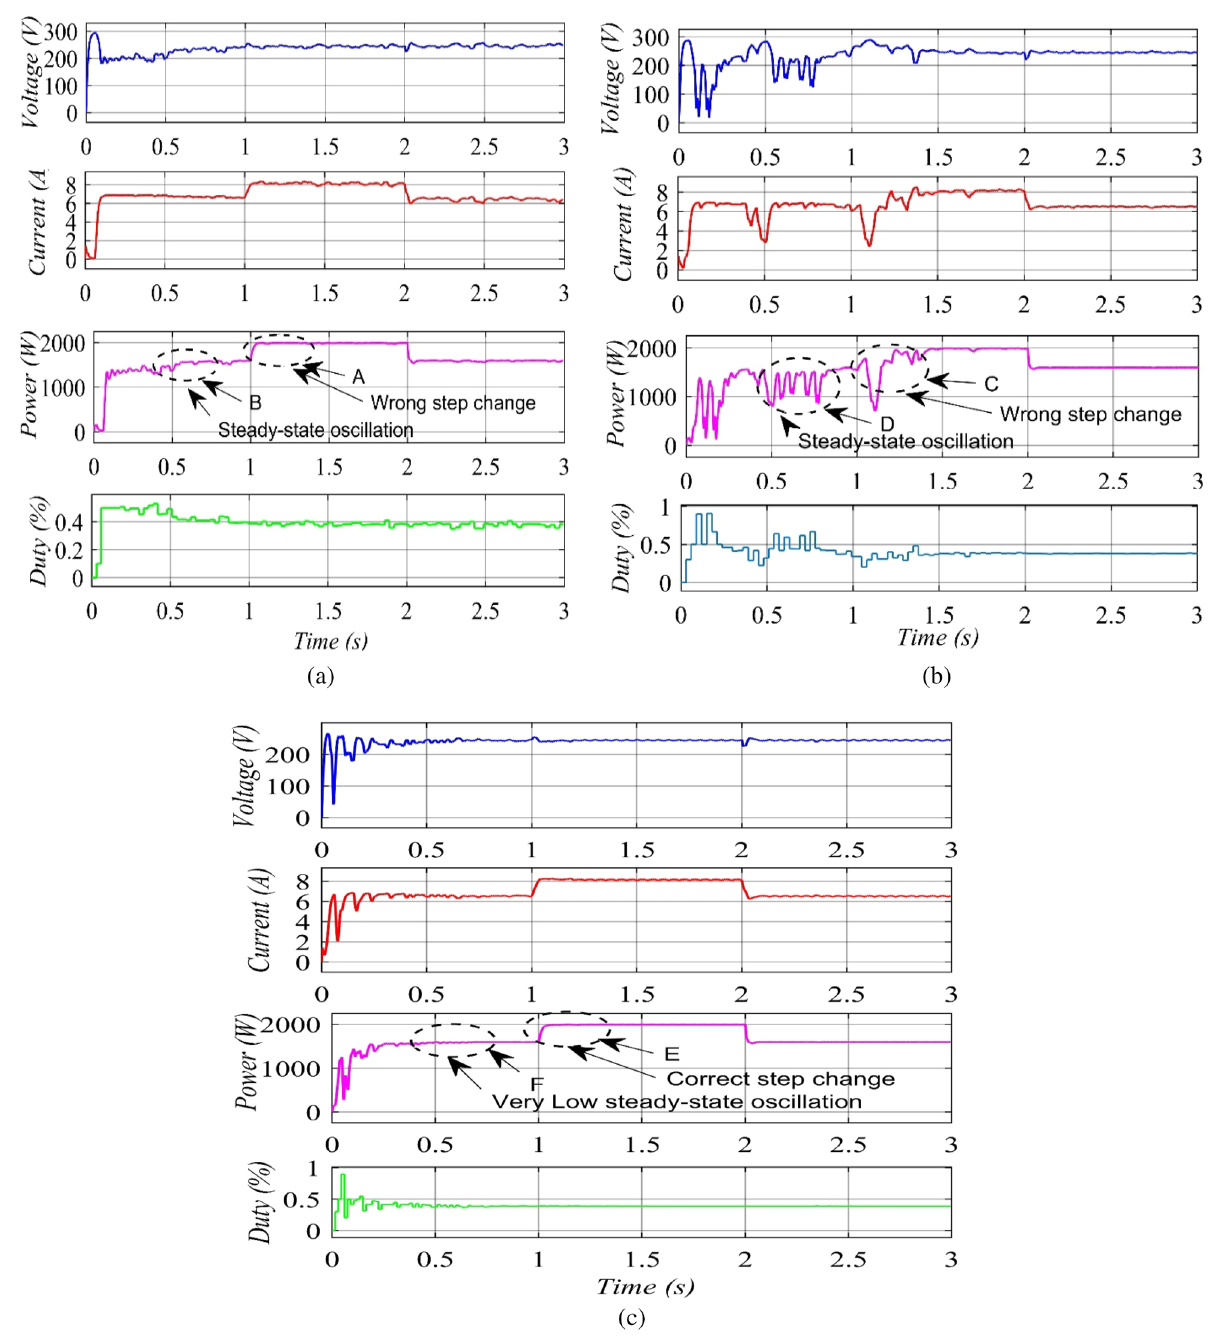
Figure 12. Simulation results: ( a ) TIC algorithm. ( b ) VSZIC algorithm. ( c ) Proposed MIC